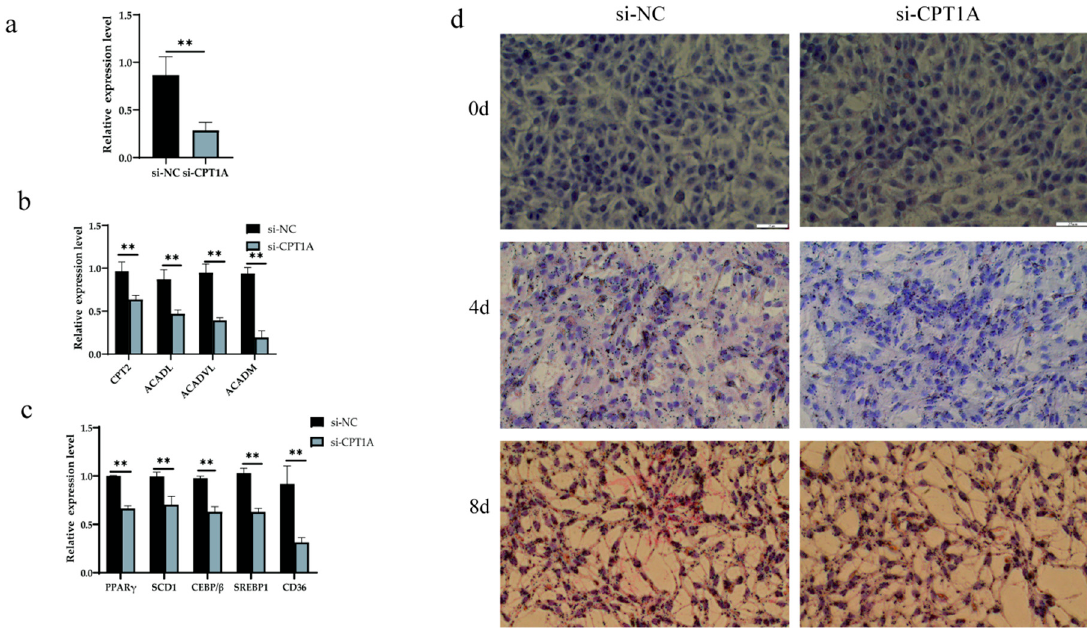
Figure 9. Effect of si CPT1A on lipid metabolism in BMECs. Data are given as the mean ± SD for n = 3/group. ** p < 0.01 were considered statistically significant. ( a ) Gene interference efficiency, ( b ) expression of genes downstream of CPT1A in CPT1A -silenced cells, ( c ) expression of lipid metabolism genes, and ( d ) lipid droplet formation in BMECs after CPT1A silencing.